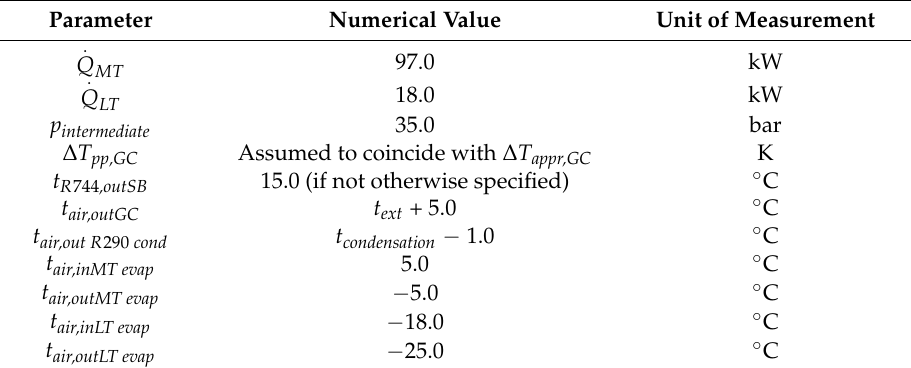
Table 3. Assumptions in common in all the implemented analyses